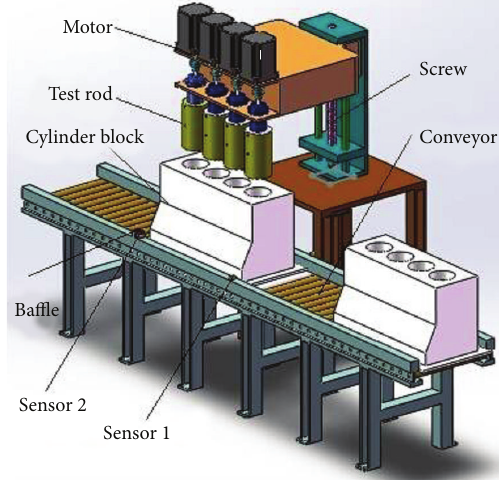
Figure 2: Cylindricity error measuring device.